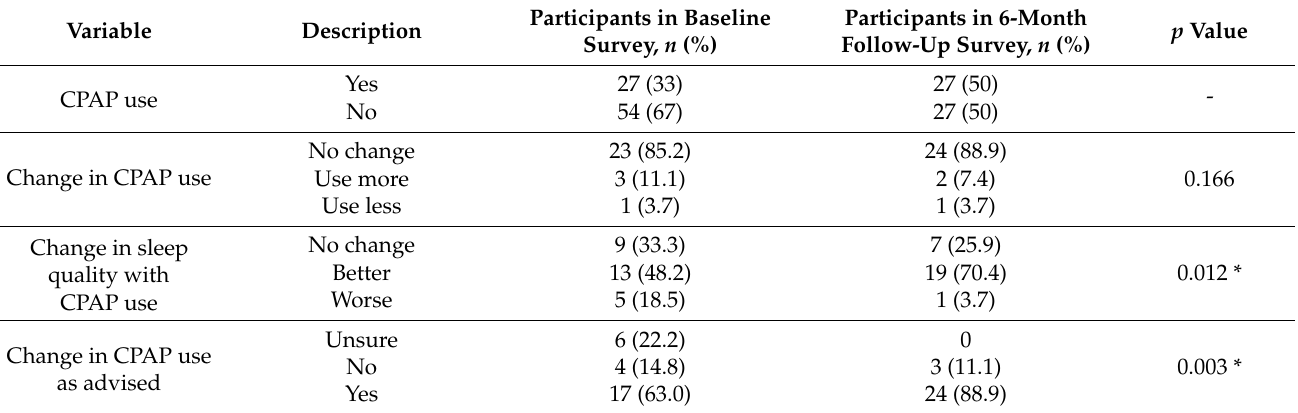
Table 2. Longitudinal analysis of CPAP use during COVID-19 pandemic using chi-square associa- tion testing.